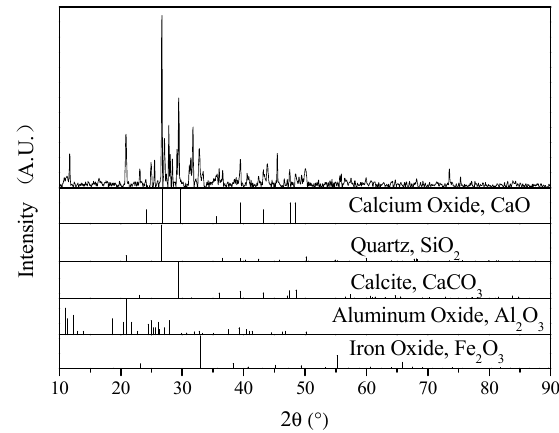
Figure 1. X-ray diffraction (XRD) diffractograms of municipal solid waste fly ash. Figure 1. X-ray di ff raction (XRD) di ff ractograms of municipal solid waste fly